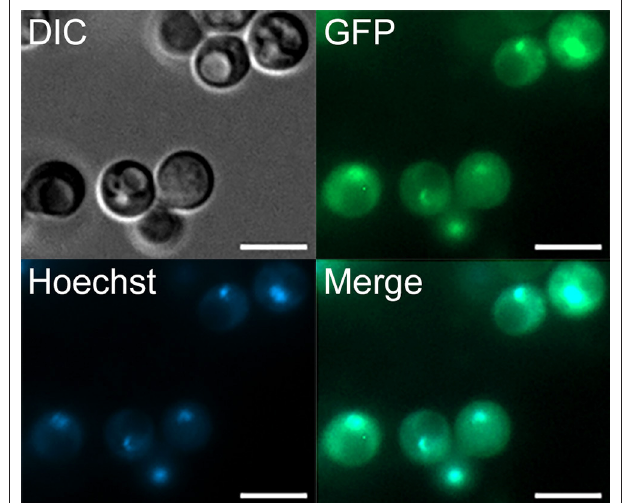
FIGURE 7 | The Rcv1-GFP chimera localizes to the nucleus. The RCV1-GFP strain was grown for 16h on YPD at 30 ◦ C before cells from the culture were applied to a microscope slide. Rcv1-GFP cells were stained with Hoechst 33342, showing that the nuclear stain co-localizes with the GFP signal. Bar, 5 µ m. DIC, differential interference contrast microscopy. See Methods for